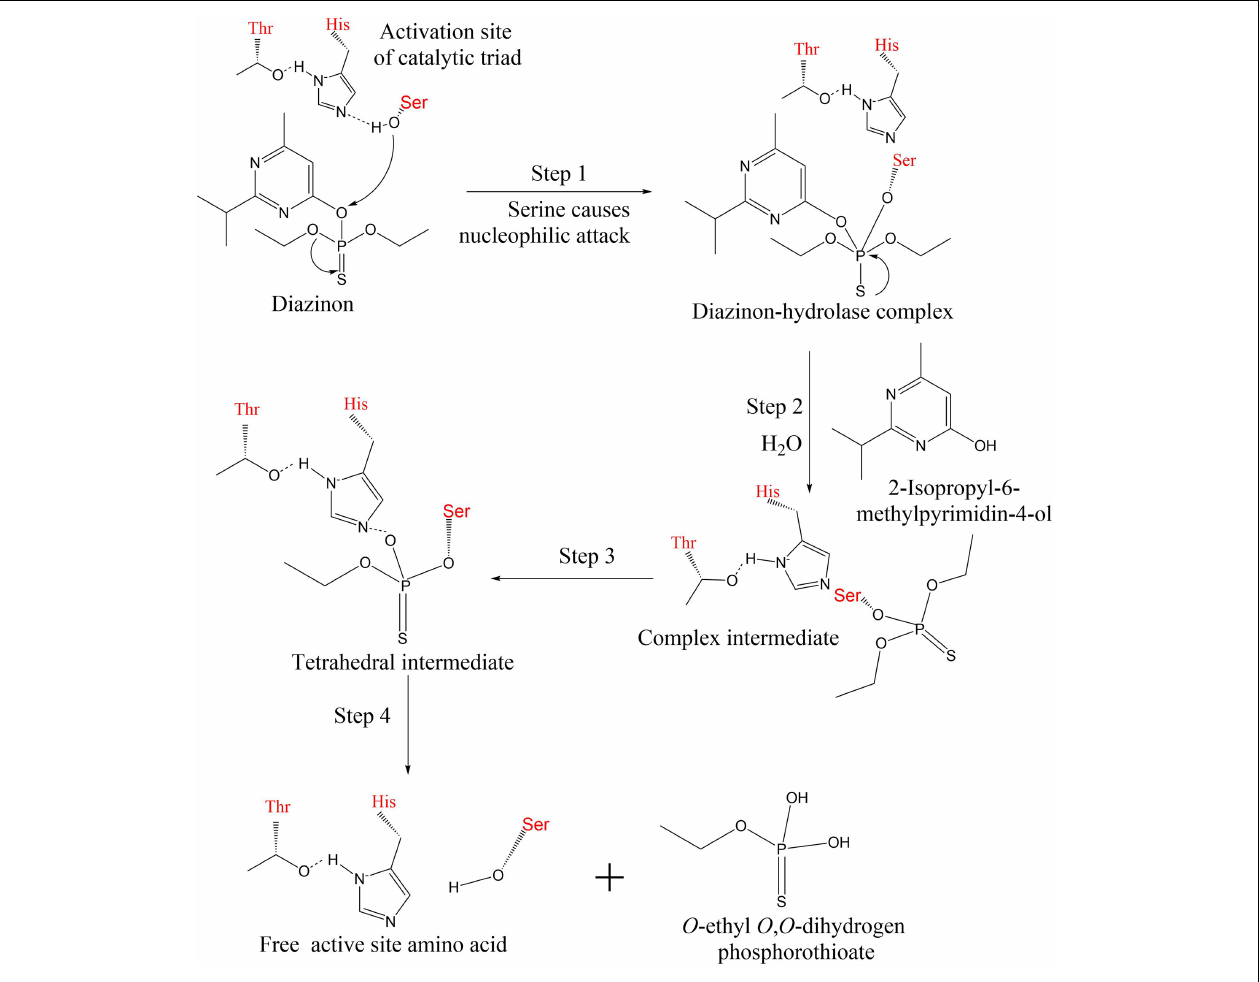
FIGURE 5 | The specific enzymatic catalytic process of diazinon. The active site of organophosphorus hydrolase contains three amino acids (serine, histidine, threonine or glutamine) (Bhatt et al., 2020a; Huang et al., 2021). The hydroxyl group of serine takes part in nucleophilic reactions during diazinon